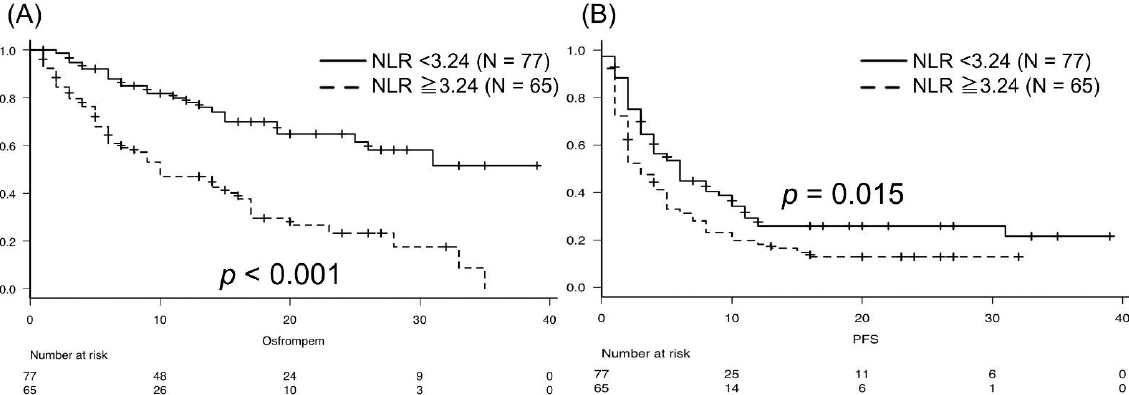
Figure 4. According to NLR, patients with NLR < 3.24 did not achieve the median OS, and those with NLR ≥ 3.24 had a median OS of 10 months ( p < 0.001; ( A )). The median PFS was 6 months in patients with NLR < 3.24 and 3 months in patients with NLR ≥ 3.24 ( p = 0.015; ( B )).